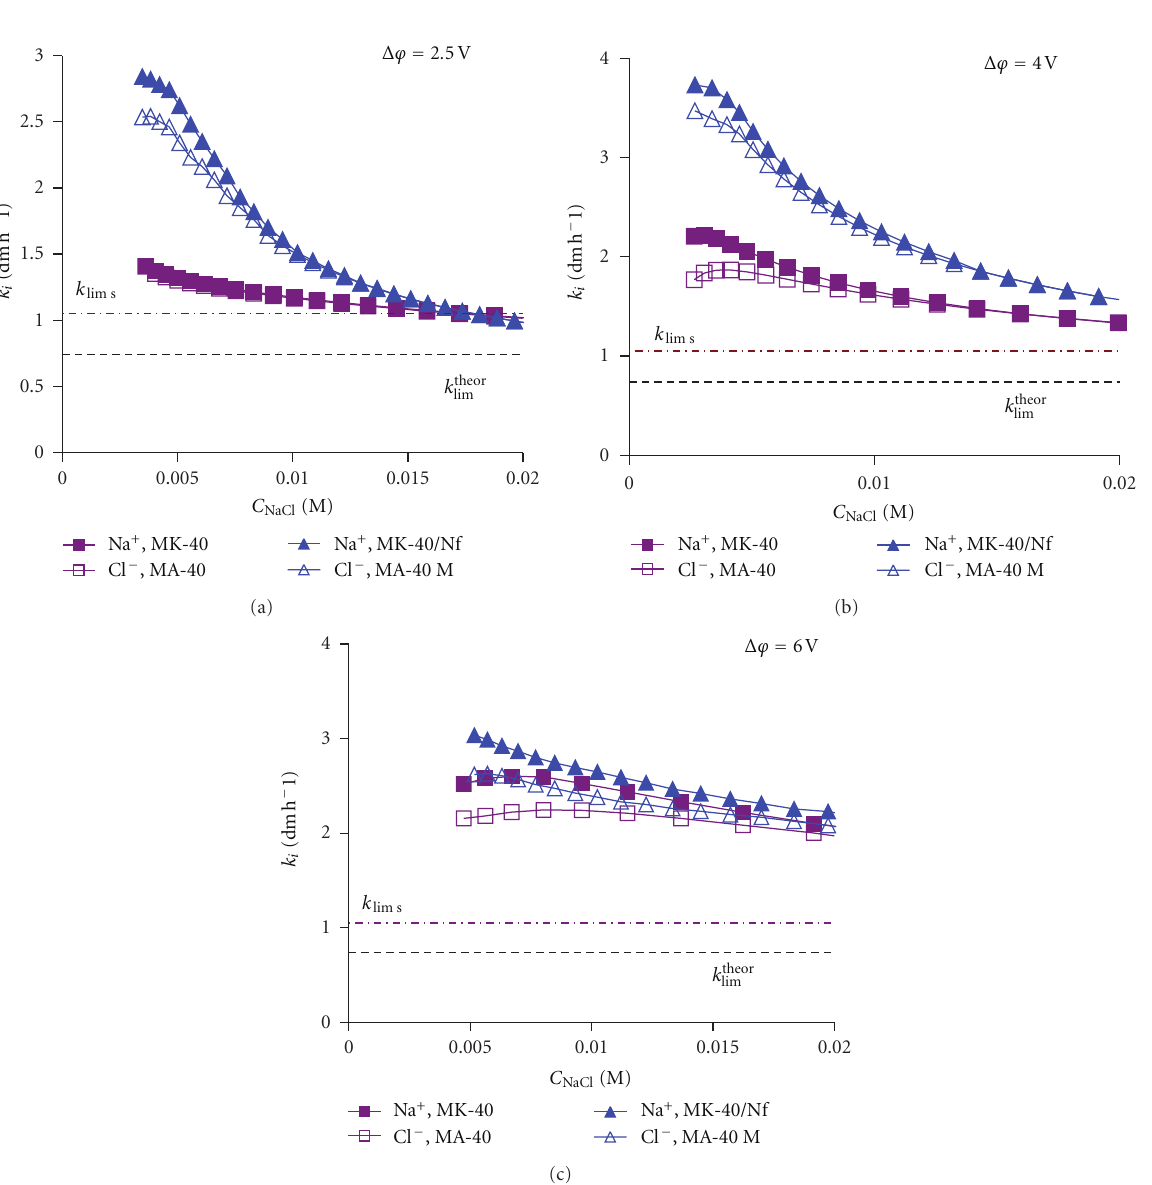
, is calculated lim